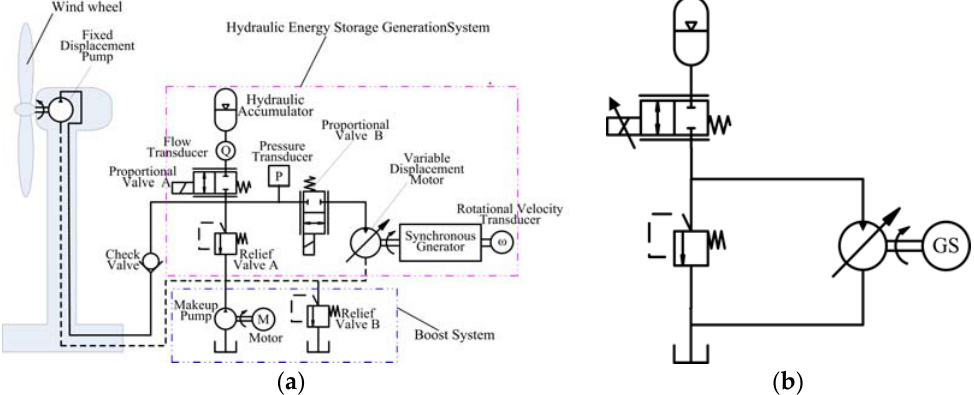
Figure 1. Principle of the novel hydraulic wind turbine and hydraulic energy storage generation system (HESGS). ( a ) Hydraulic wind turbine with hydraulic energy storage system; ( b ) Hydraulic energy storage generation system.